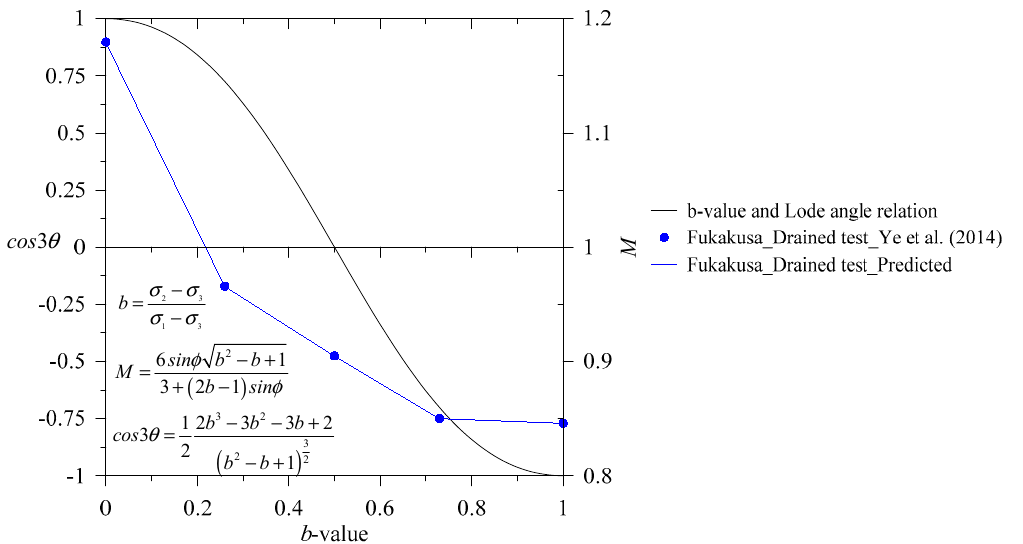
Figure 5. Relations of b -value-Lode Angle and b -value- M (see also Lade [29]; Islam and Gnanendran [23]; Ye et al. [30] ).